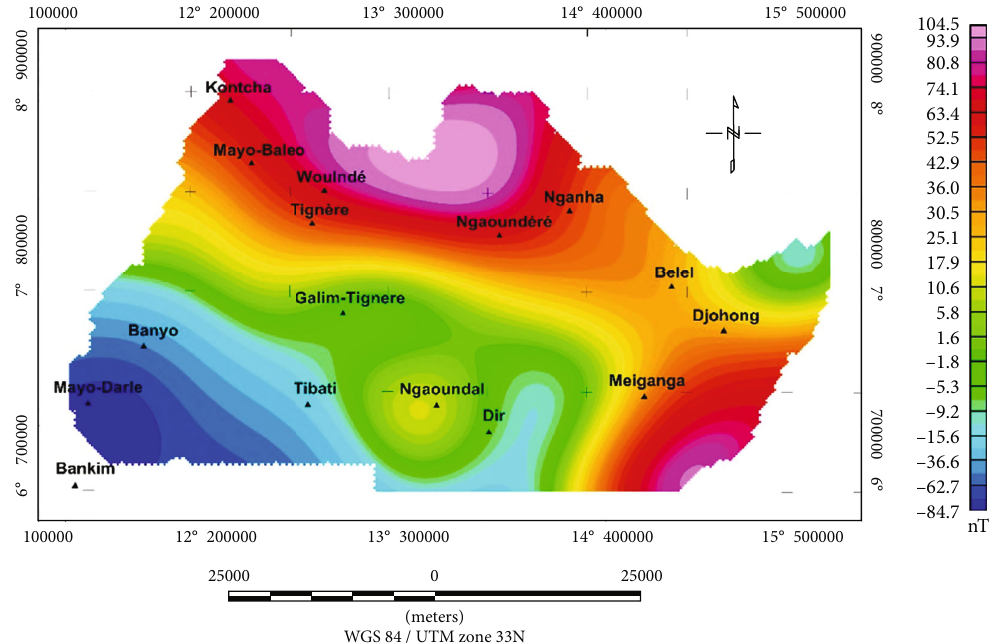
Figure 4: Regional magnetic anomaly map of Adamawa